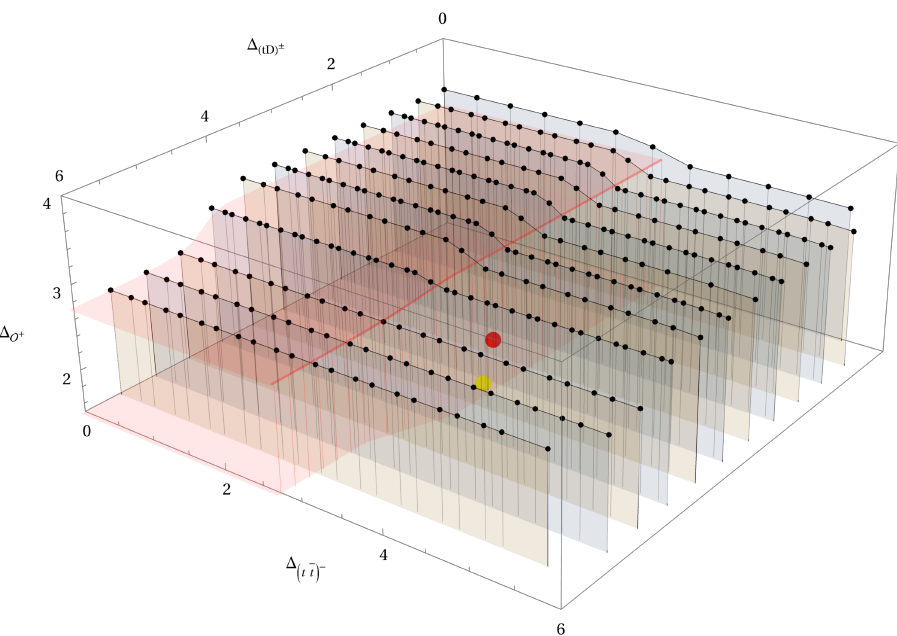
Figure 5. Bounds on the dimension of the first S -parity even singlet O + in the t × ¯ t and the D × ¯ D OPEs as a function of the scaling dimension of ( t D ) ± and ( t ¯ t ) − . The GFB solution, given in eq. (2.25), is shown in red. The ε -expansion results for the magnetic line defect are given in yellow. The light-shaded region represents the results for the agnostic bound ∆ Λ = 33 , P = 63